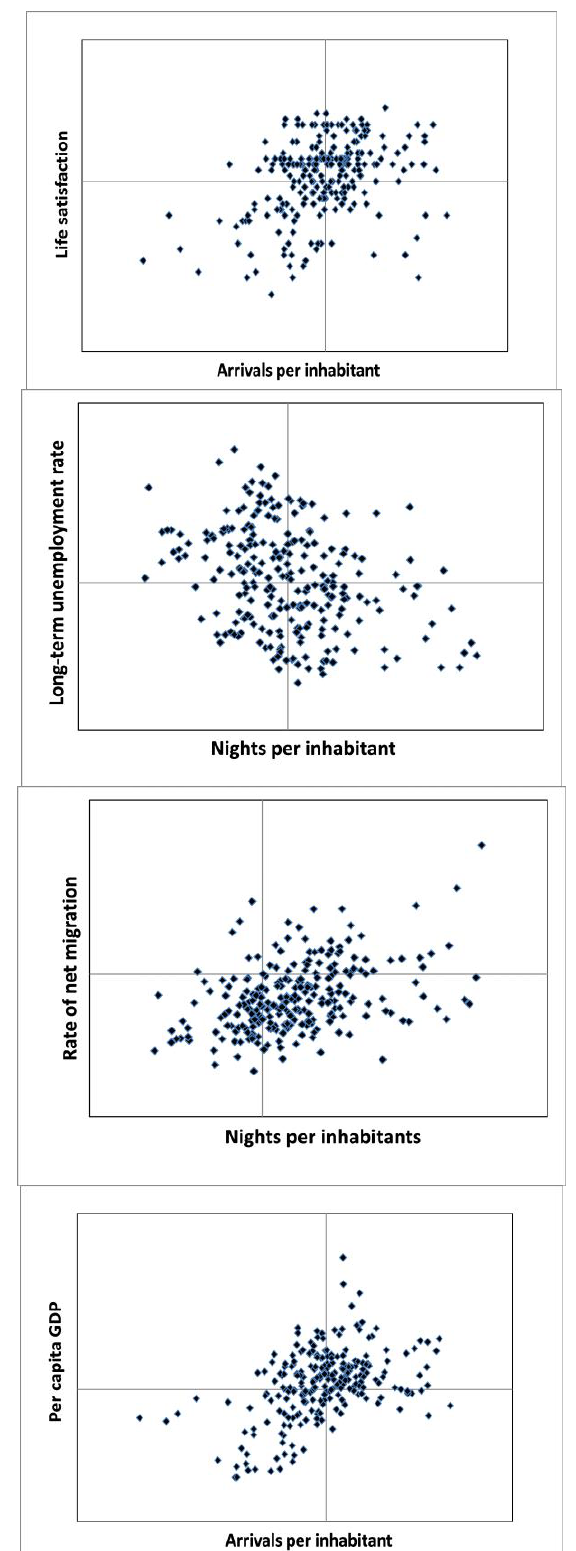
Figure 3: The Relation between Tourism and Local Development in European